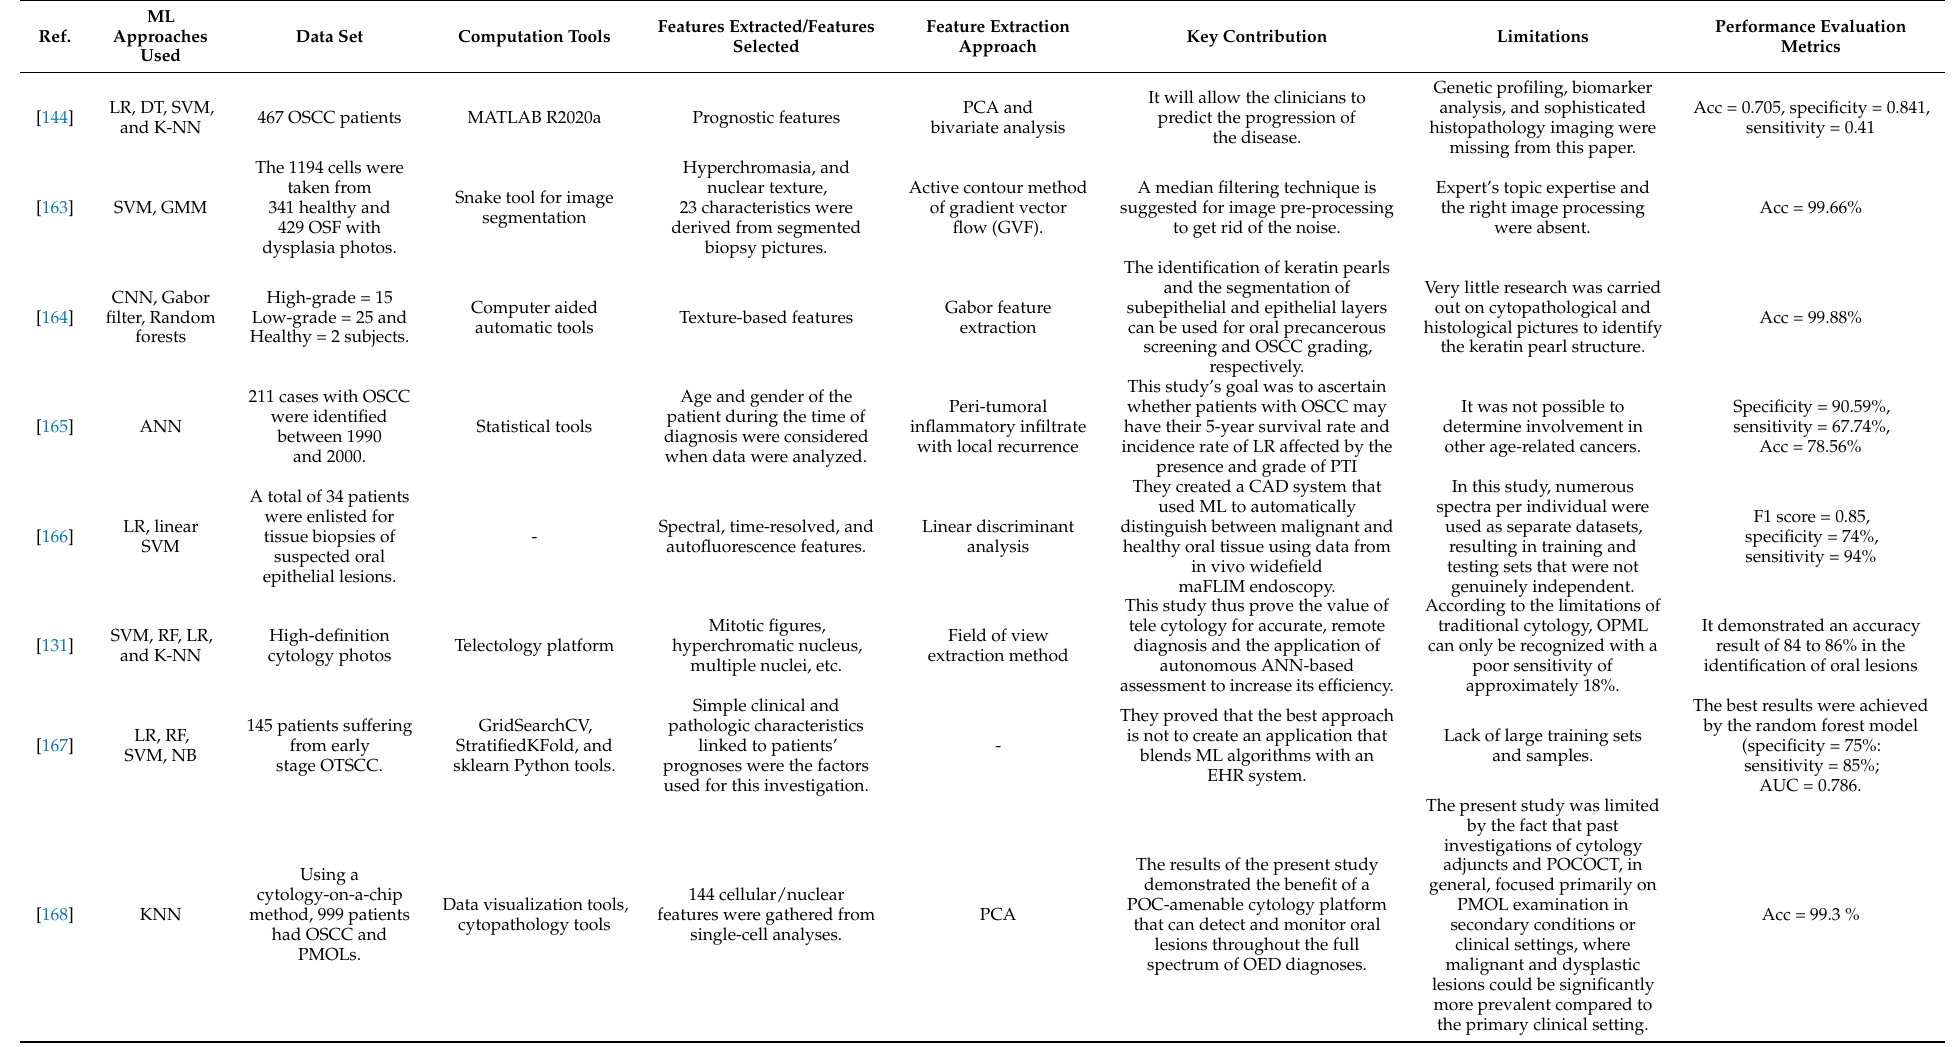
Table 3. A list of articles on ML models for oral cancer